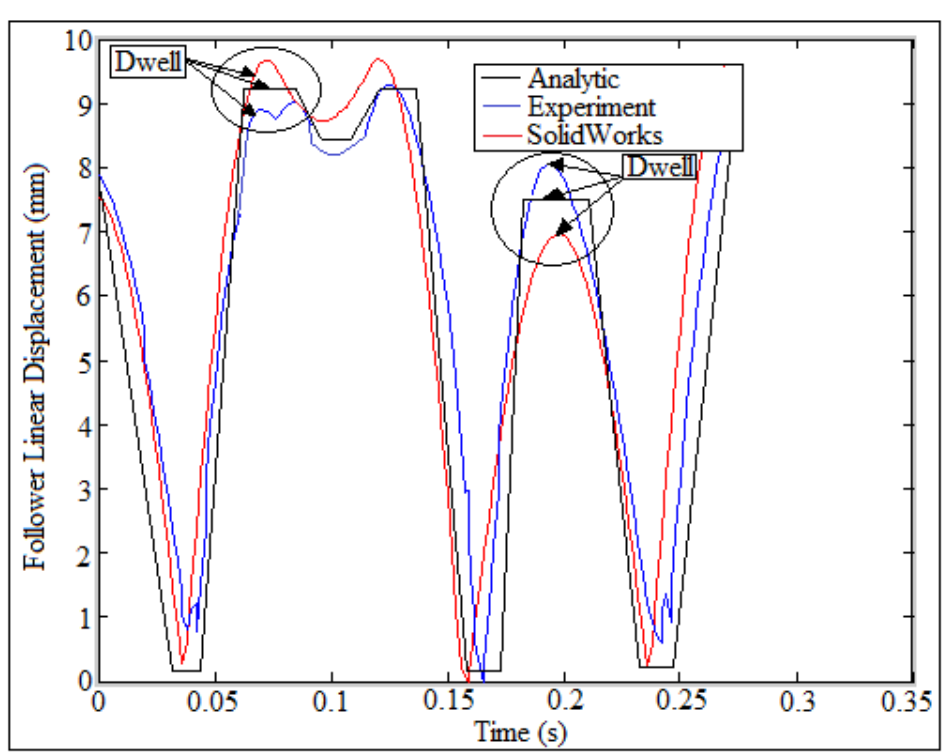
Figure 14. Comparison of follower displacement.